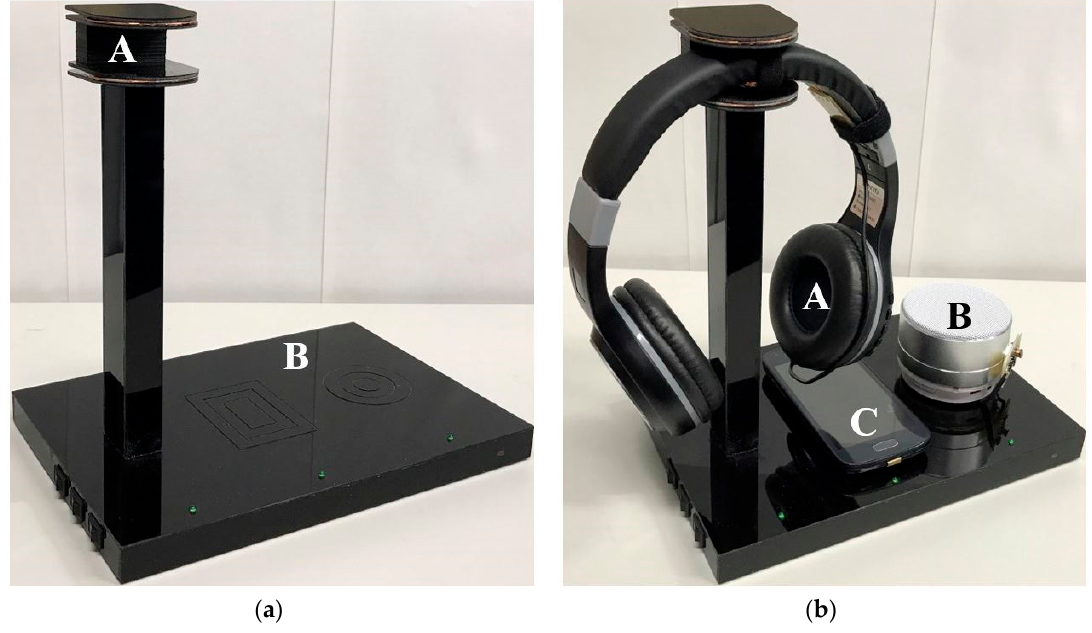
Figure 18. ( a ) Wireless power hanger and pad prototype (part A is THE hanger charger pad and part B is the charger pad); ( b ) Portable electronic devices charging configuration on the developed device prototype (part A is wireless headphone, part B is wireless audio speaker, and part C is cell phone).